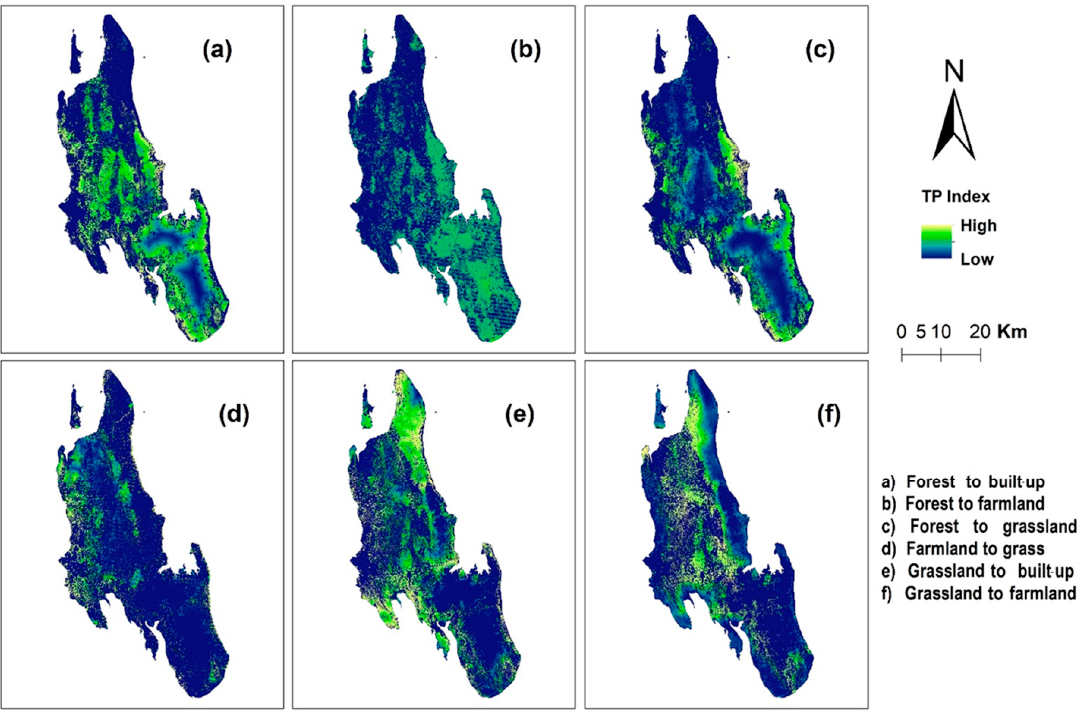
Figure 5. Transition potentials (TP) 2003–2009.